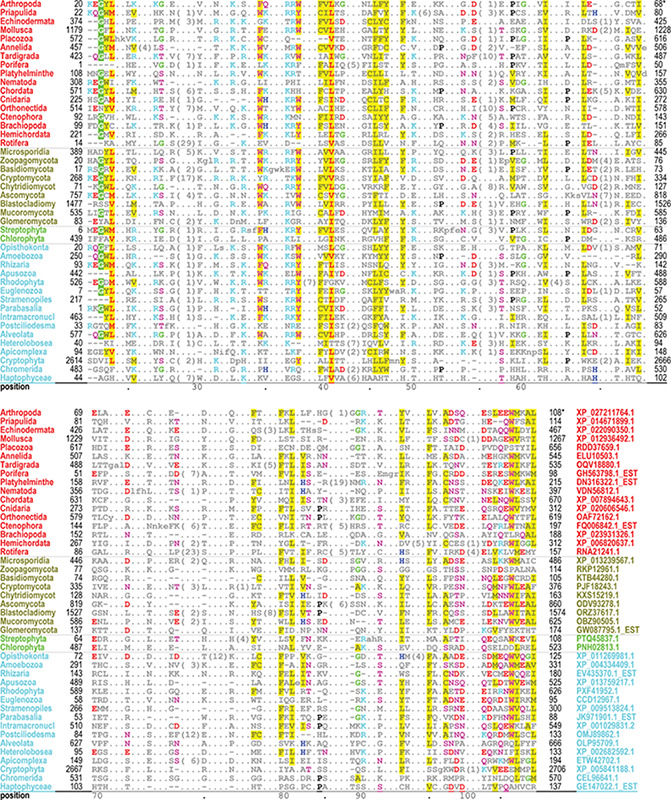
Alignment of 42 representative, distantly related PH domains from distinct phyla and sharing ≤25% identity. Despite the weak similarity and an abundance of indels, conserved residues characteristic of this superfamily are generally well aligned. Residues generally conserved in `all’ PH domains are colored as follows: acidic residues, red (without highlighting); basic residues, cyan; hydrophilic residue, pink; histidine, glycine and proline, blue, green and black, respectively; hydrophobic and aromatic residues, red (highly conserved) or gray with yellow highlighting. Identifiers for phyla (left column) and sequences (right column in lower aligned region) are color coded by taxa as follows: metazoan, red; fungal, dark yellow; plant, green; protozoan, cyan.